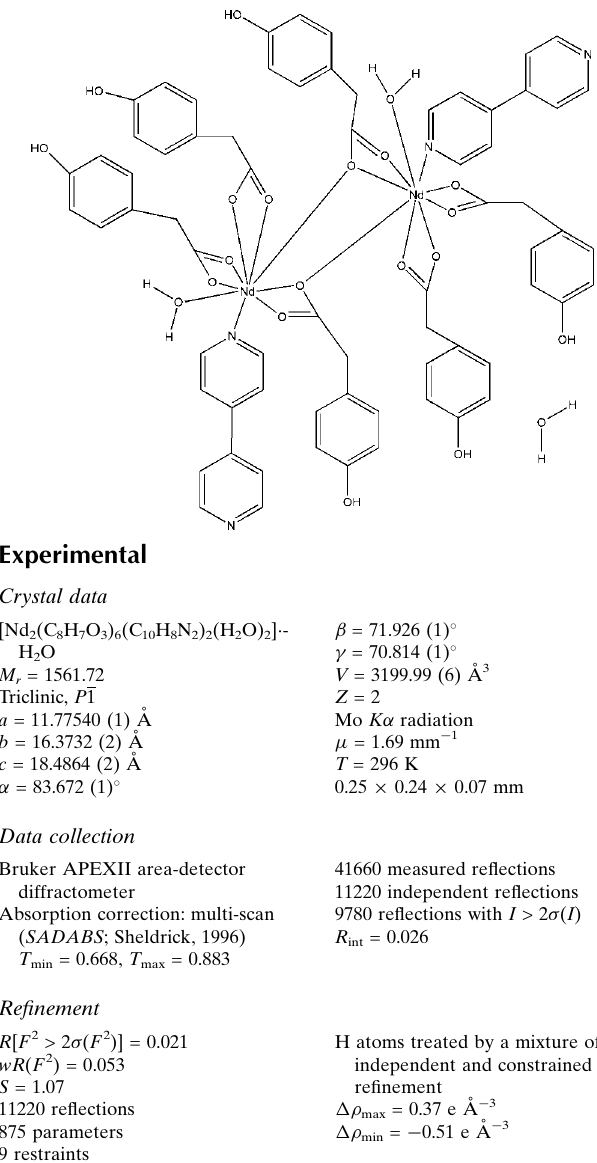
Related literature